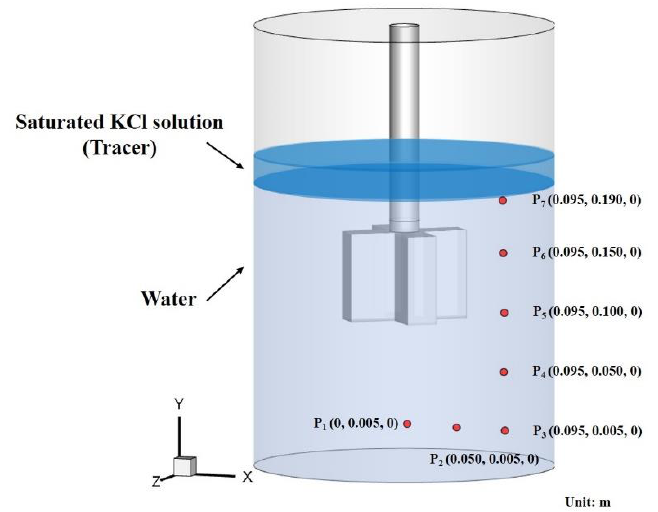
Figure 2. Schematic illustration of tracer addition region and the position of monitoring points with detailed coordinates.